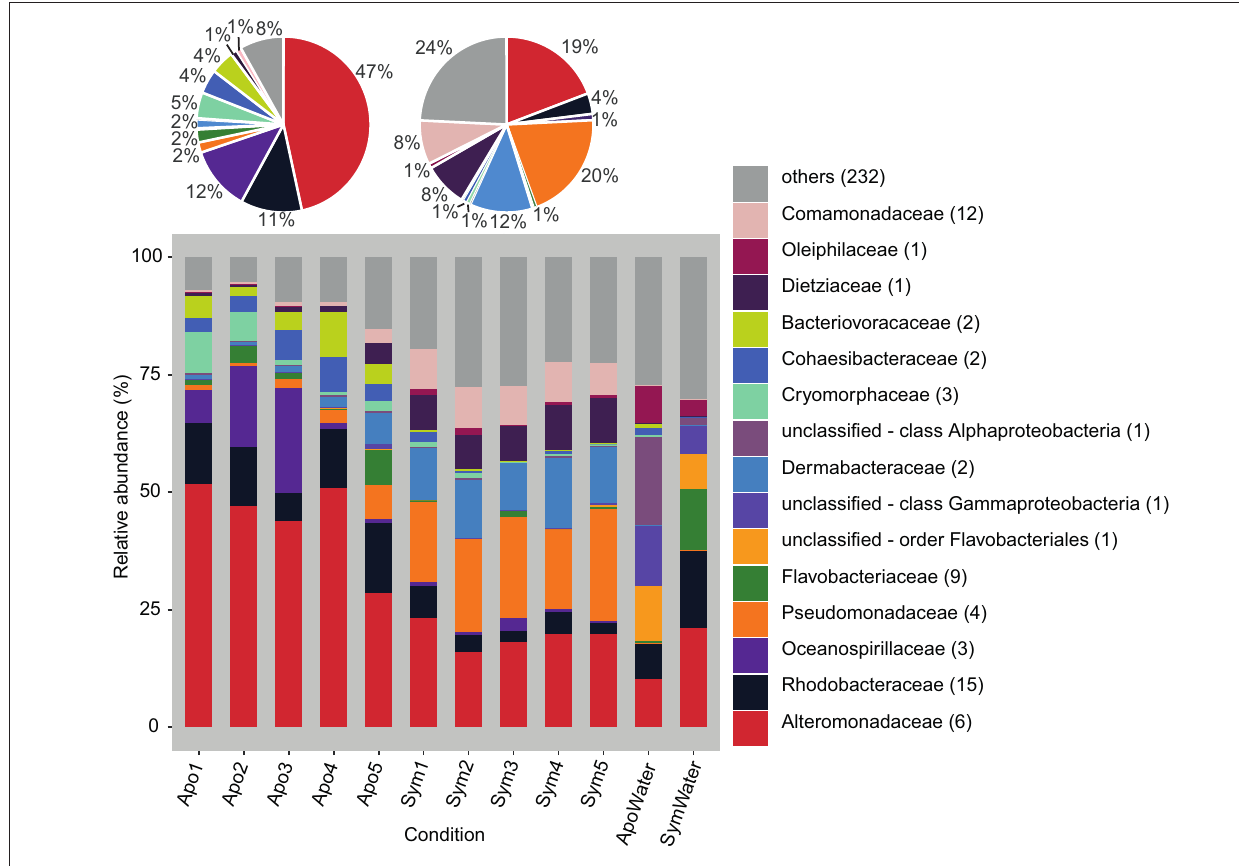
FIGURE 1 | Bacterial community composition on the phylogenetic level of family (Greengenes database, bootstrap ≥ 60). Each color represents one of the 15 most abundant families across all samples. Less abundant families are grouped under “others.” Pie charts display average bacterial community composition of aposymbiotic (left) and symbiotic (right) Aiptasia . Sequences unclassified on the family level are denoted at the next higher classified taxonomic level. Numbers in parenthesis demark the number of different taxa within the respective families. Apo, aposymbiotic Aiptasia ; Sym, symbiotic Aiptasia ; WaterApo, water from rearing of aposymbiotic Aiptasia ; WaterSym, water from rearing of symbiotic Aiptasia